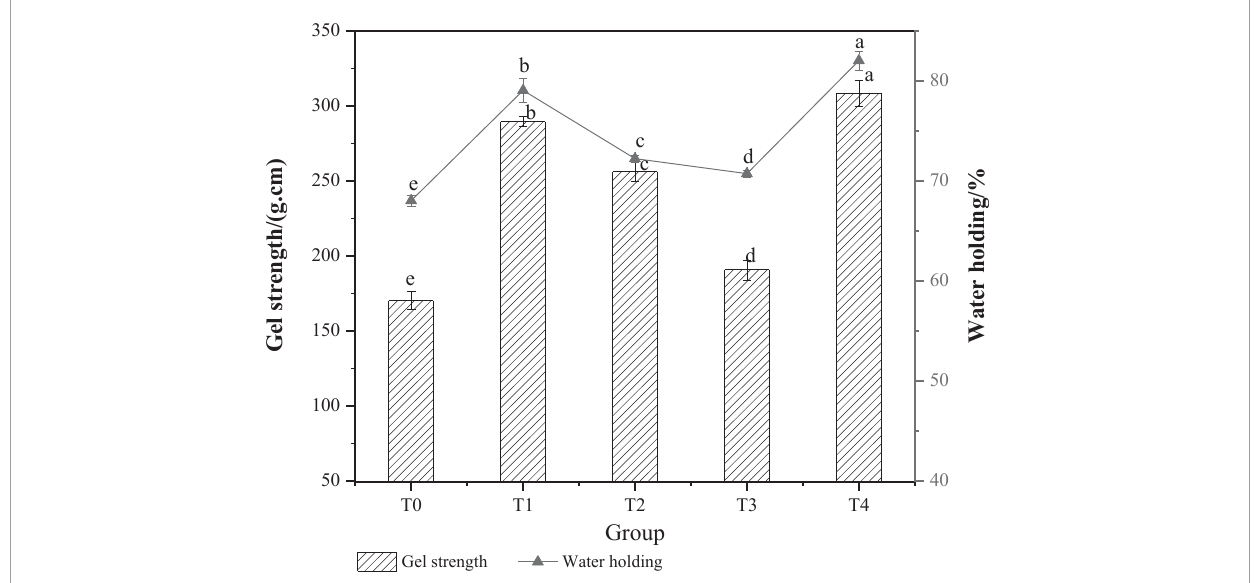
FIGURE2 Effect of composite dietary fiber on MP gel strength and water retention. T0: control group; T1: 6.06% chaff dietary fiber; T2: 6.06% soybean hull dietary fiber; T3: 6.06% inulin; T4: 1.40% chaff dietary fiber +1.42% soybean hull dietary fiber +3.24% inulin; a–e: different letters indicated significant differences among the samples ( P < 0.05).